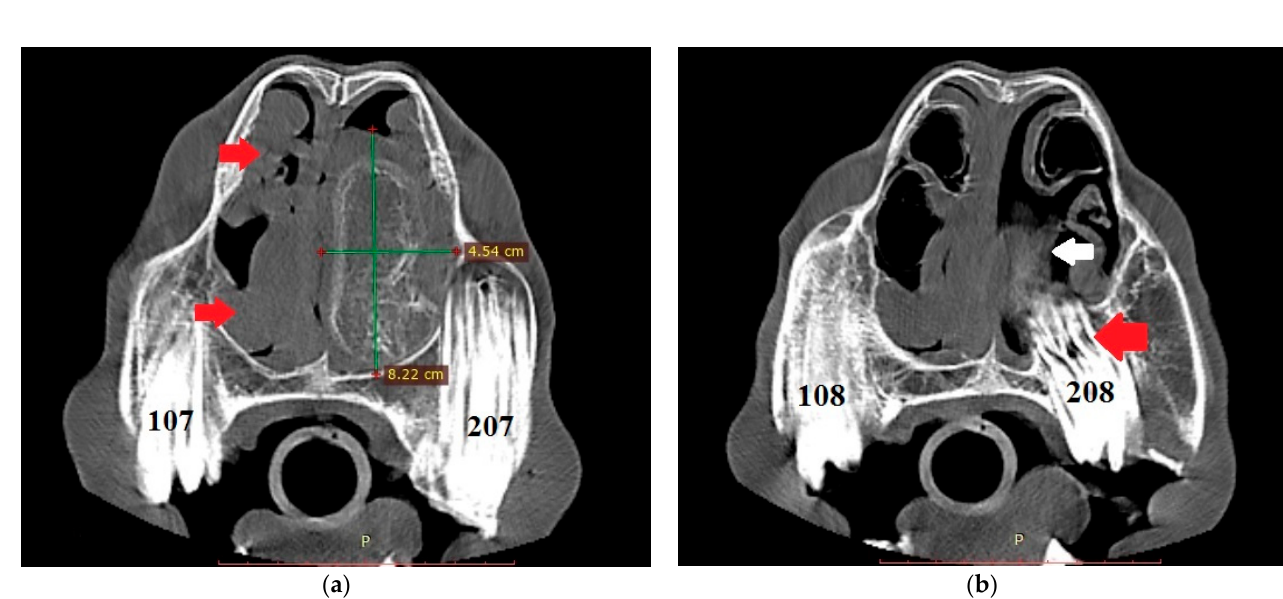
Figure 3. Sagittal CT image obtained left to sagittal line (bone algorithm, WW1500, WL 300). The mass length × height are indicated with green lines. Connection between the mass and the Triadan 208 is present (green arrow).